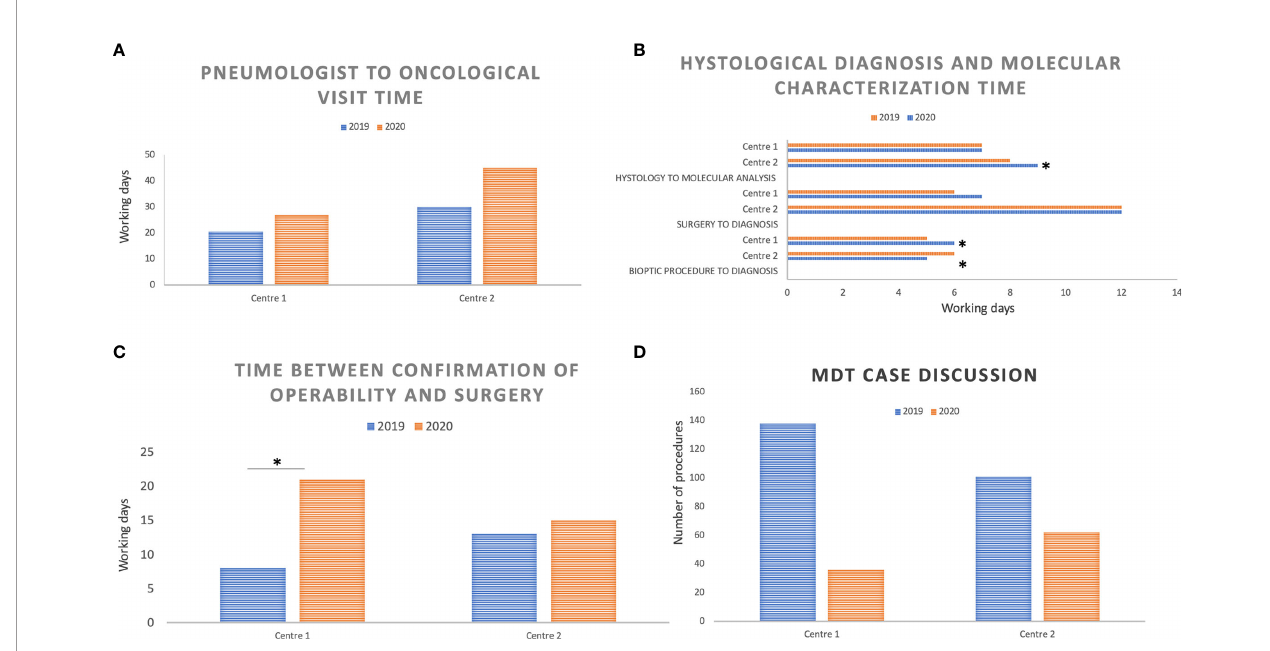
FIGURE 3 | Median performance time reported in working days and compared between March and April 2019 versus March and April 2020 at the two Centers: (A) Time interval between the pneumology assessment and the fi rst oncological visit; (B) Time interval between the biopsy or surgical procedure and the histological diagnosis, and between the histological diagnosis and molecular results; (C) Time interval between the con fi rmation of operability based on functional assessment and surgery (lobectomy or pneumonectomy); (D) Number of cases discussed by the multidisciplinary team (MDT) at the two Centers in March and April 2019 compared with March and April 2020. *Indicates statistically signi fi cant differences between 2019 and 2020; p signi fi cance level: